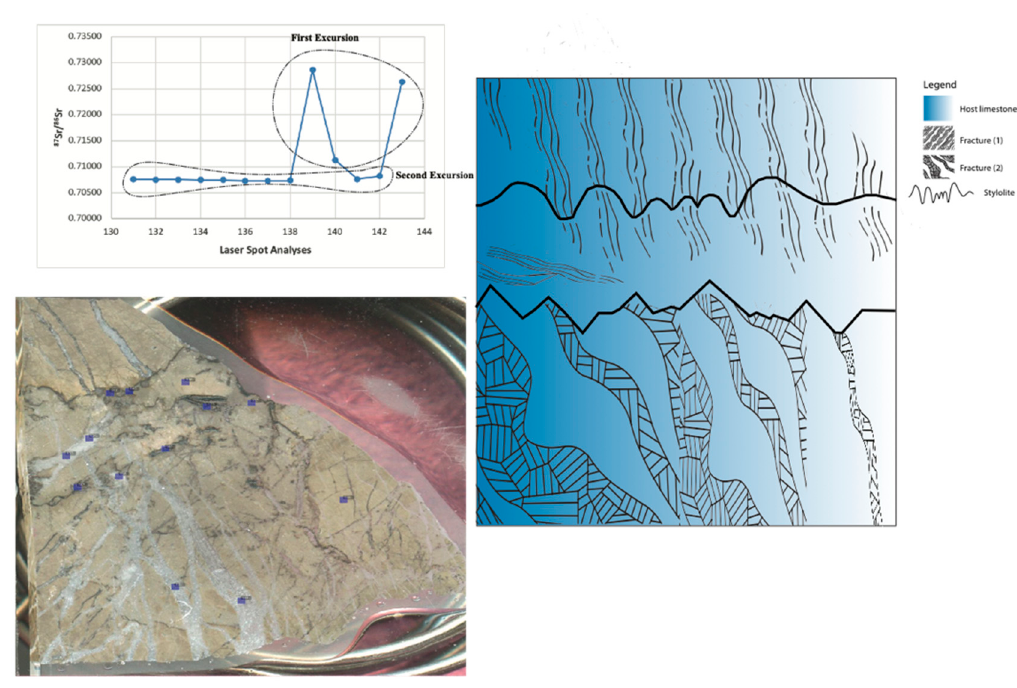
Figure 10. The absolute radiogenic strontium isotope values v. the location of the spot analysis “sample No. B14”. The location of analysis is represented by cubic blue colour where the ablated spot size used is 213 µm and depth of crater is ~20 µm.